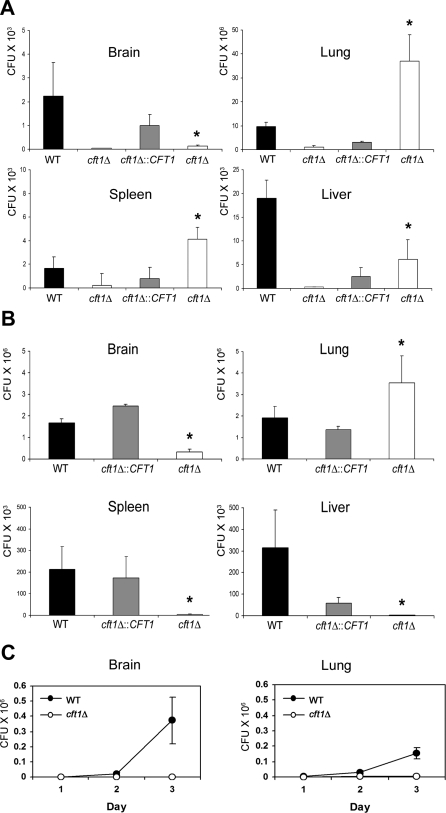
The cft1 Mutant Shows Reduced Tissue Colonization in a Mouse Model of Cryptococcosis(A) Distribution of fungal cells in the organs of mice infected by the inhalation method. Organs from mice infected with the wild-type strain, the cft1 mutant or the CFT1 reconstituted strain were collected at day 19 when the wild type and the reconstituted strain reached the end point. Additionally, organs from mice infected with the cft1 mutants were collected at day 34 when mice reached the end point. Fungal burdens were monitored in organs by determining colony-forming units (CFU) upon plating on YPD medium. Three mice for each strain were used at each time point. Data are average CFUs per organ with standard deviations. CFUs for the cft1 mutant at day 34 are marked with an asterisk; the other counts are from day 19.(B) Distribution of fungal cells in mice infected by the tail vein injection method. Organs from mice infected with the wild-type strain or the CFT1 reconstituted strain were collected at day 7 when the wild type and the reconstituted strain reached the end point. Organs from mice infected with the cft1 mutants were collected at day 29 when mice reached the end point. Fungal burdens were monitored as described in (A). Three mice for each strain were used. Data are averages with standard deviations. CFUs for the cft1 mutants at day 29 are marked with an asterisk; the other counts are from day 7.(C) The ability of the cft1 mutant to colonize brain and lung tissue was compared with the wild-type strain. Mice were inoculated with 2.5 × 105 cells by tail vein injection, sacrificed at the times indicated and analyzed for fungal burden.